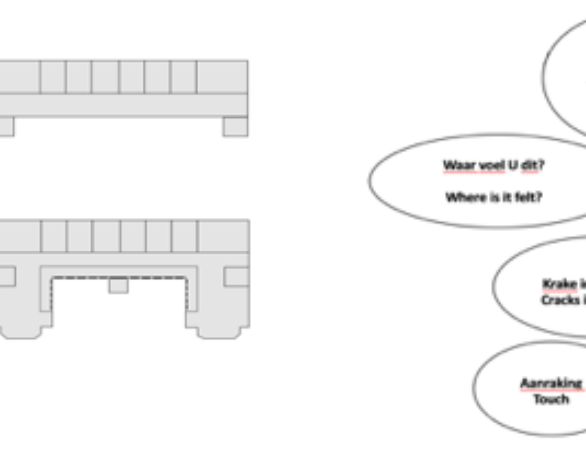
Figure 17 : The Lückhoff School floor plan